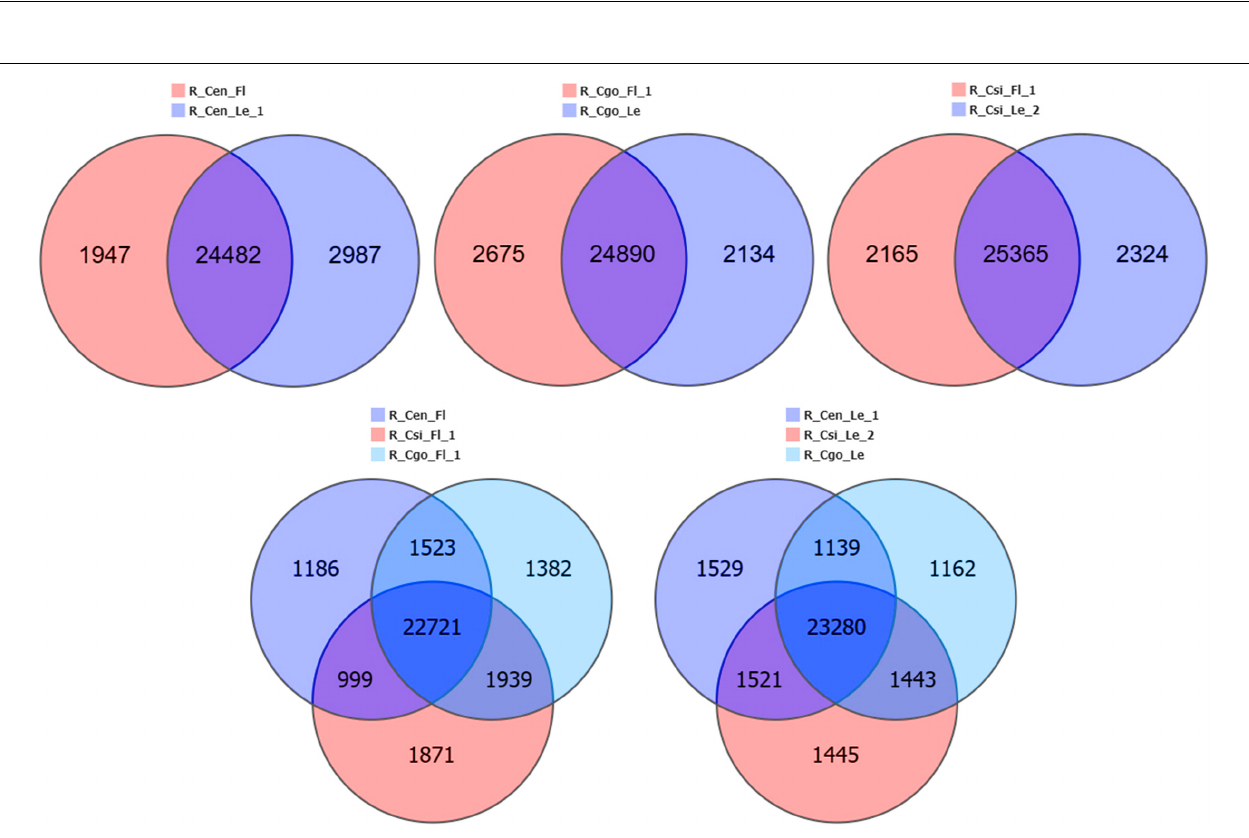
FIGURE 3 | Tissue-specific and common differentially expressed genes (DEGs) among the flower and leaf samples of three orchid species.